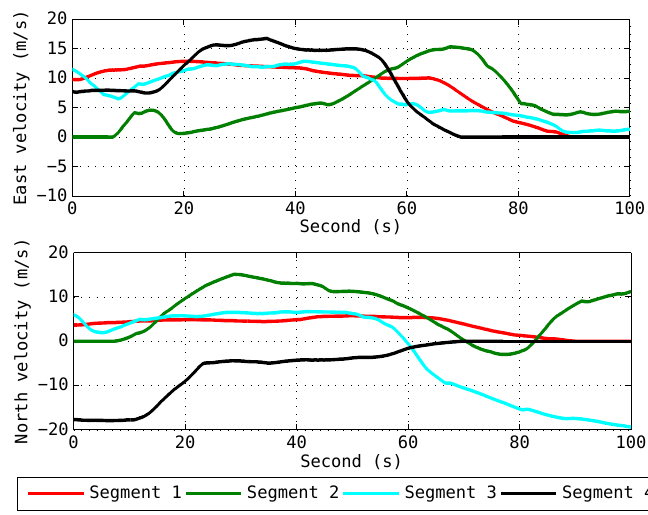
Figure 6. Velocity profile for four